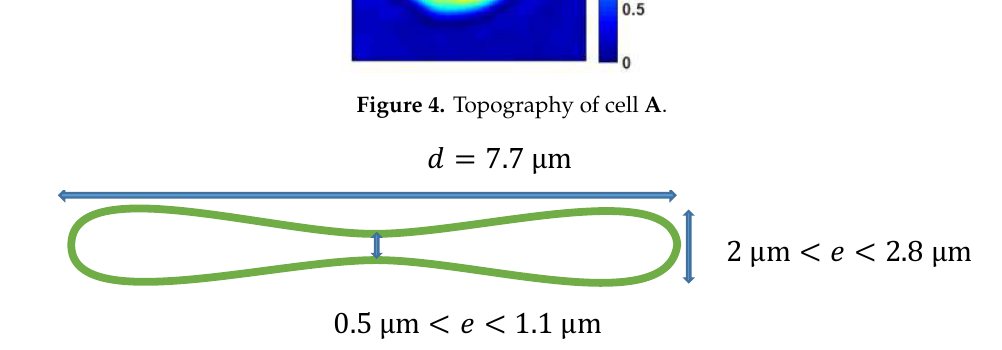
Figure 5. Experimental dimensions for cell A.